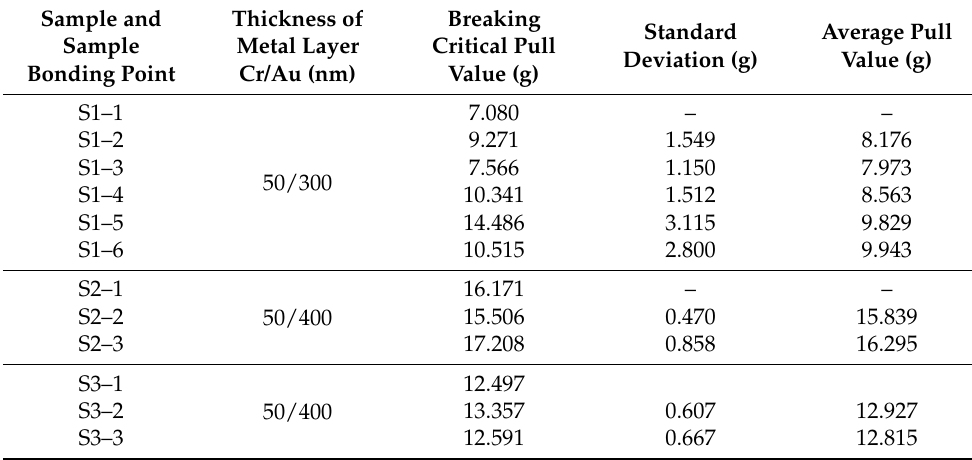
Table 2. Pull test of different bonding points on the same experimental